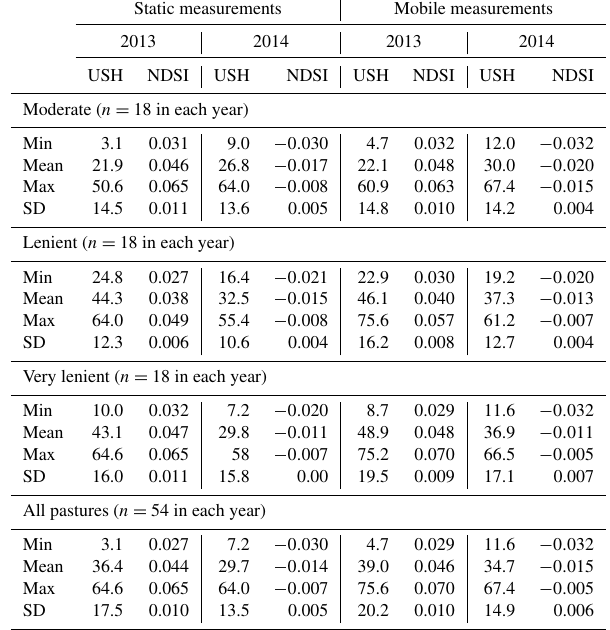
Table 1. Summary statistics of static and mobile measurements of ultrasonic sward height (USH) (cm) and normalized difference spectral index (NDSI) on reference plots of pastures with different stocking rates in 2013 and